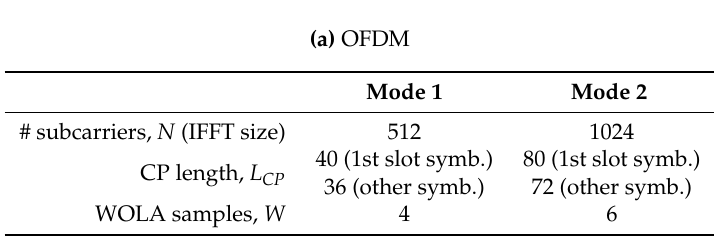
Figure 4. Periodograms for OFDM, FBMC, and UFMC baseband signals. Table 1. Waveform